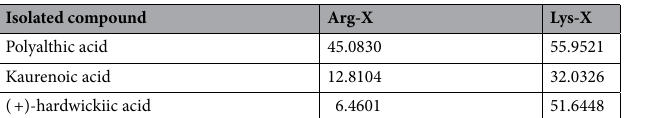
Table 2. GoldScore fitness results obtained for the binding of the isolated compounds polyalthic, kaurenoic acid and ( +)-hardwickiic acid into the active sites of Arg-X and Lys-X